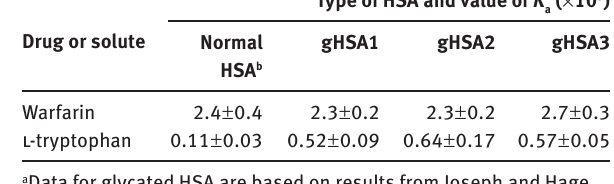
) for warfarin and a